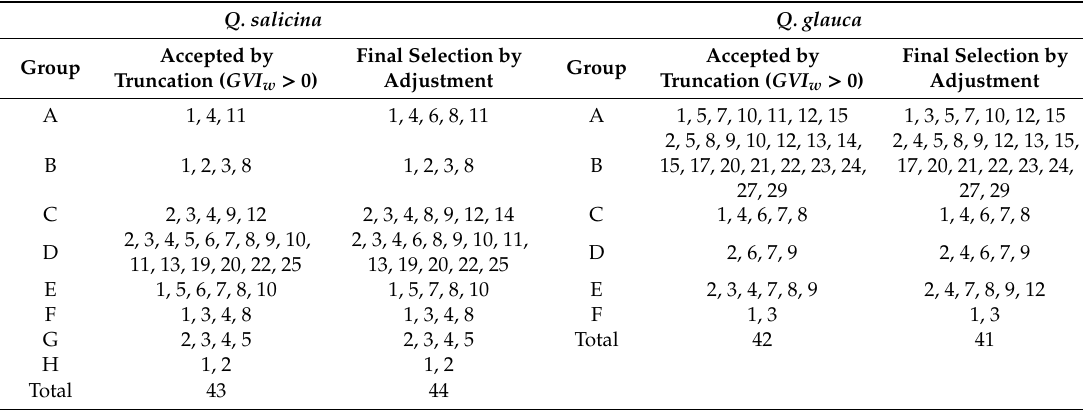
Table 6. Final list of plus trees selected by truncation ( GVI w > 0) and adjustment in Quercus salicina and Q. glauca